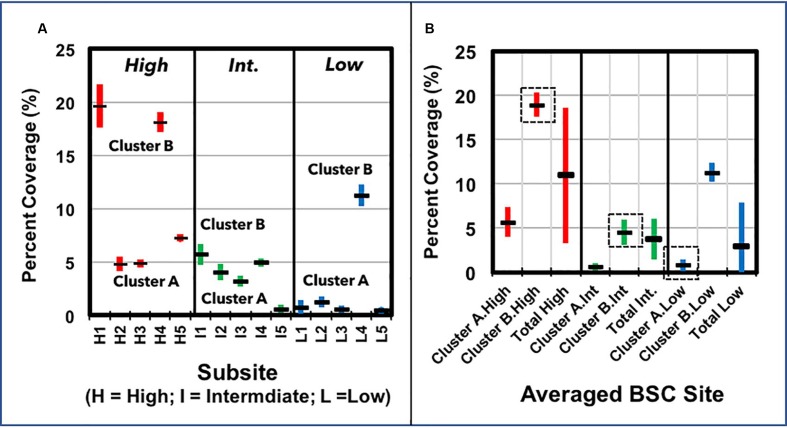
Plots of BSC surface coverage (%) across the transect, as measured by pixel analysis, showing (A) the surface densities calculated from each image (one image per grid, five grids per sampling site), with the respective clusters of values (within each site) grouped and marked as “Cluster A” and “Cluster B” (averaged surface densities are displayed as horizontal markers, and the standard deviation as vertical bars; n = 3–5, per image); and (B) the averaged BSC surface densities from Cluster A, Cluster B, and across each sampling site, where the representative values from each sampling site are marked by a dotted box (averaged surface densities are displayed as horizontal markers, and the standard deviation as vertical bars).